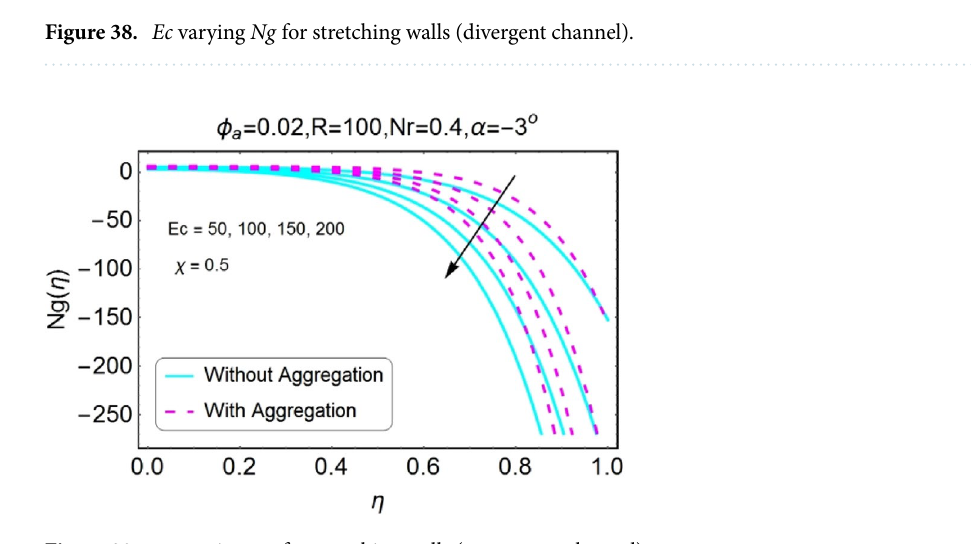
Figure 39. Ec varying Ng for stretching walls (convergent